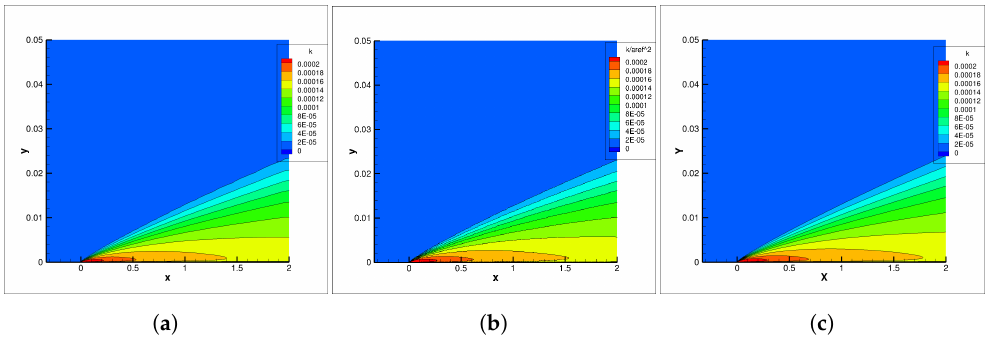
Figure 5. κ contours on flat plate using Shear Stress Transport turbulence model: ( a ) UNS3D-SEQ, ( b ) UNS3D-PAR, and ( c ) FUN3D